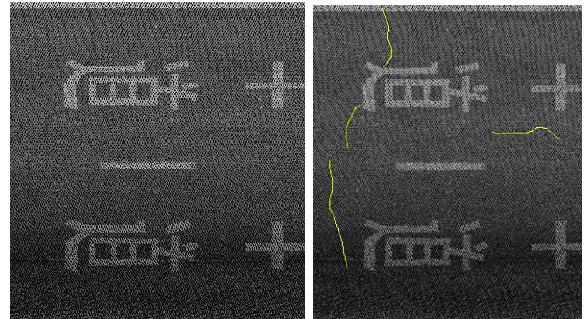
Figure 3. Compare of georeferenced intensity image (left) and classified images